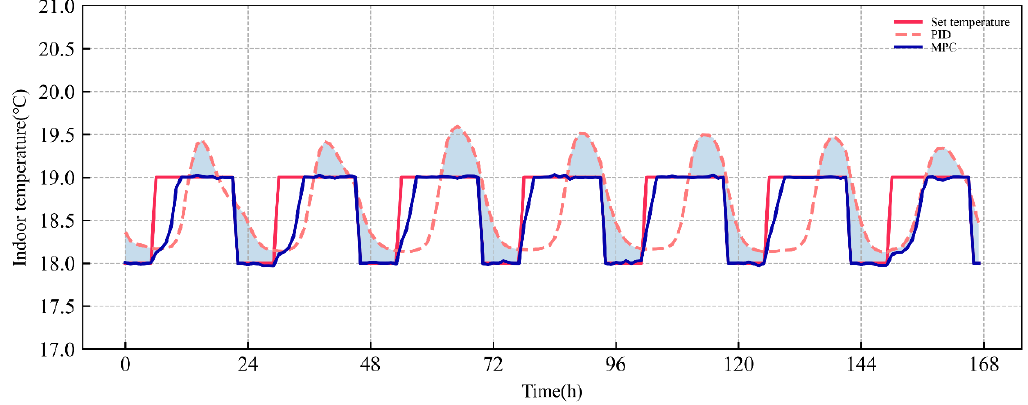
Figure 17. Comparison of the intermittent operation of PID and MPC.